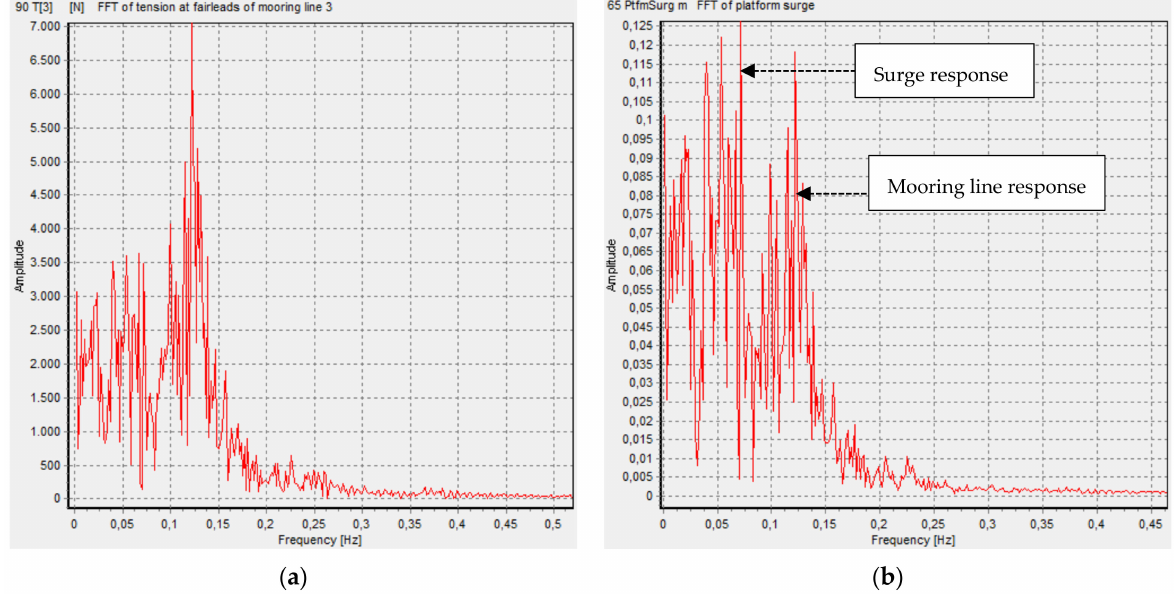
Figure 9. FFT of tension at fairlead in mooring line 3 ( a ) and surge motion ( b